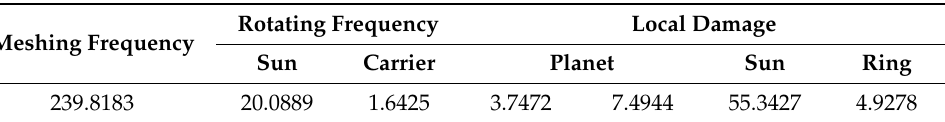
Table 3. Characteristic frequencies (Hz).